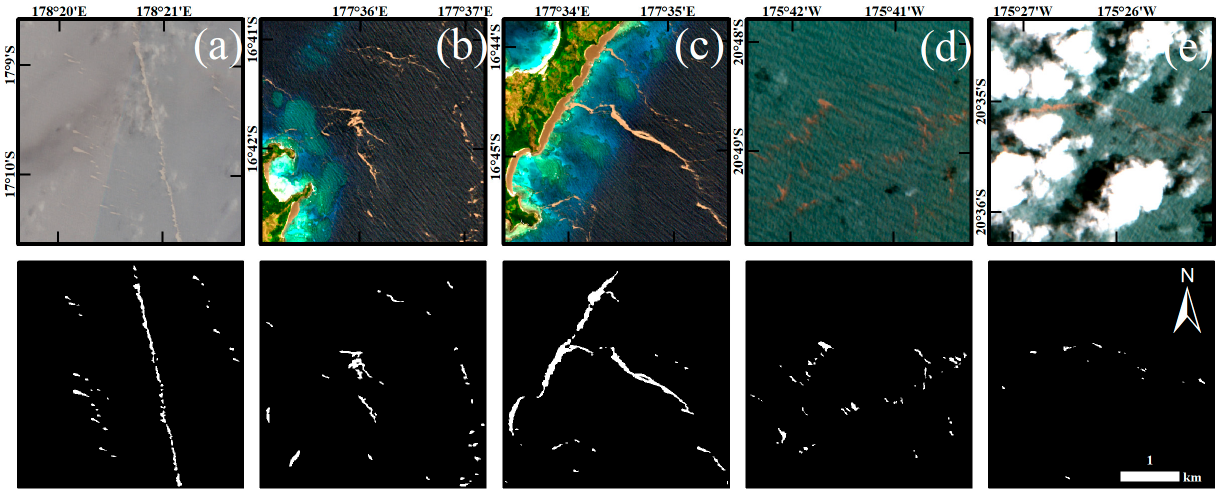
Figure 7. True color image (first row) and the extracted pumice rafts (second row) in sub-regions ( a – e ).